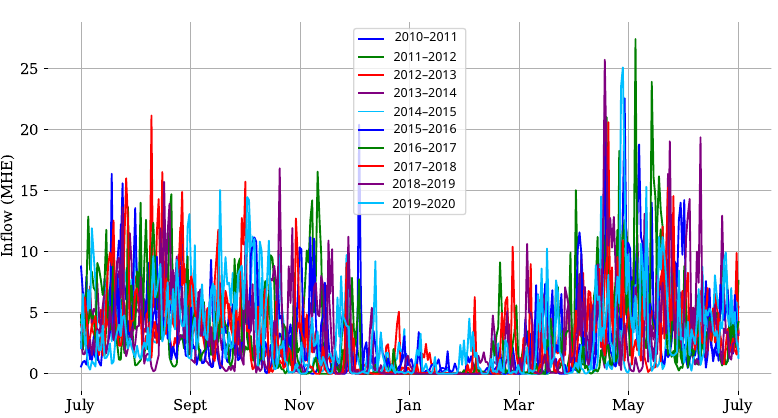
Figure 7. Synthetic historical inflow time series plot for the Ethiopian power